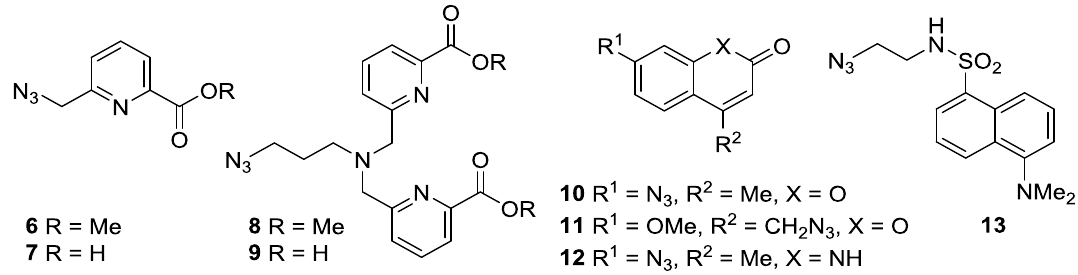
Figure 2. Fluorescent azides screened in this study.